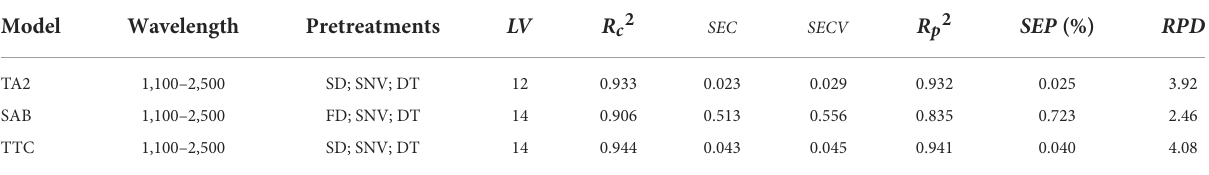
TABLE 5 The MPLS models for the quantitative determination of three quality